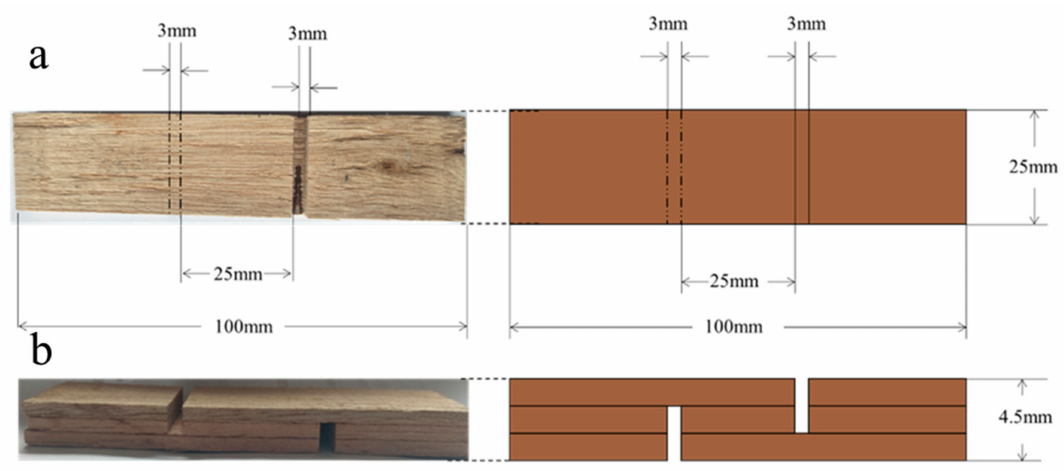
Figure 1. Specimen used for the bonding strength testing: ( a ) top view, ( b ) side